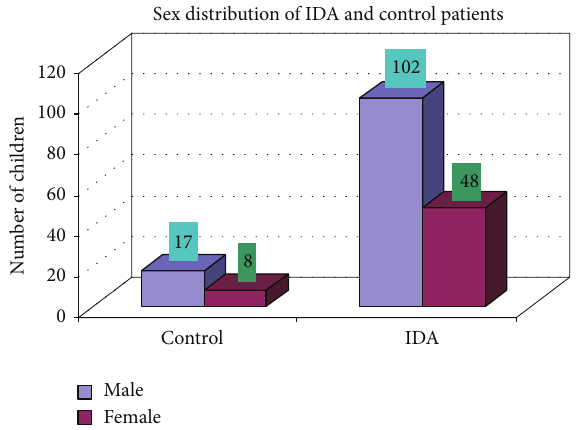
Figure 2: Showing sex distribution of IDA and control patients.